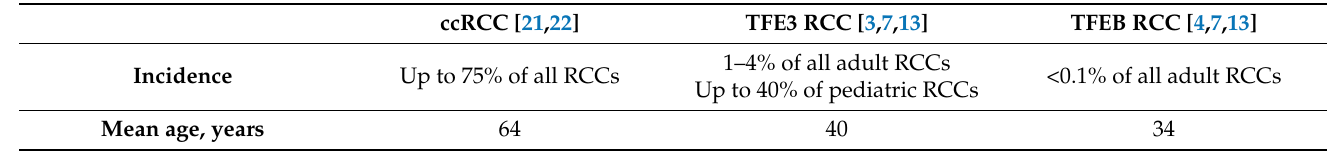
Table 1. Comparison between ccRCC and tRCC (TFE3, TFEB)